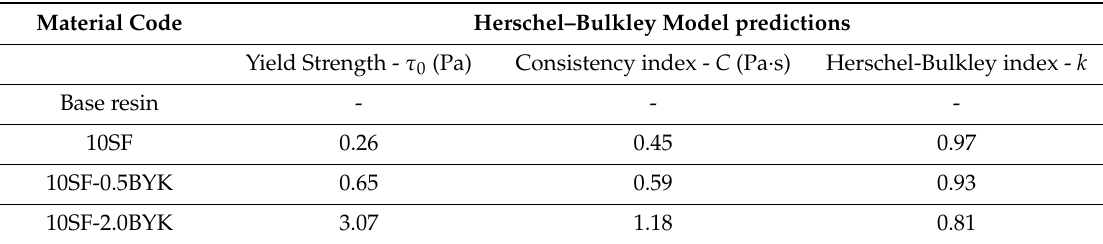
Table 3. Yield stress predictions using the Herschel–Bulkley model (Equation